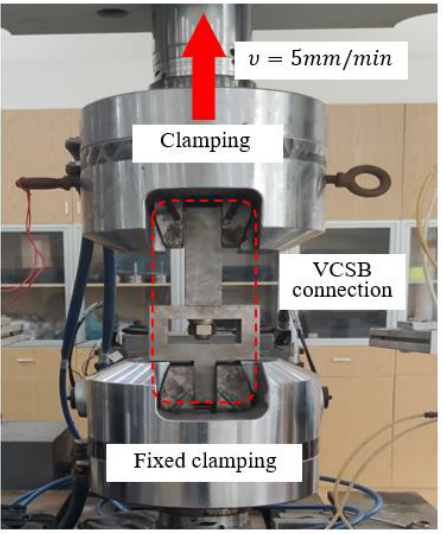
Figure 8. VCSB connections uniaxial quasi-static tensile test.